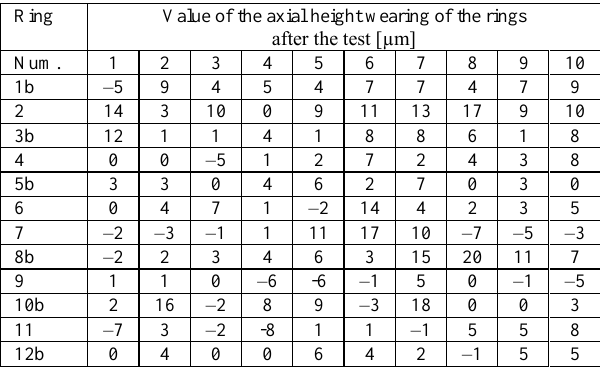
Table 4. Value of the radial thickness wearing of the rings after the test Ring Value of the radial thickness wearing of the rings after the test [µm]